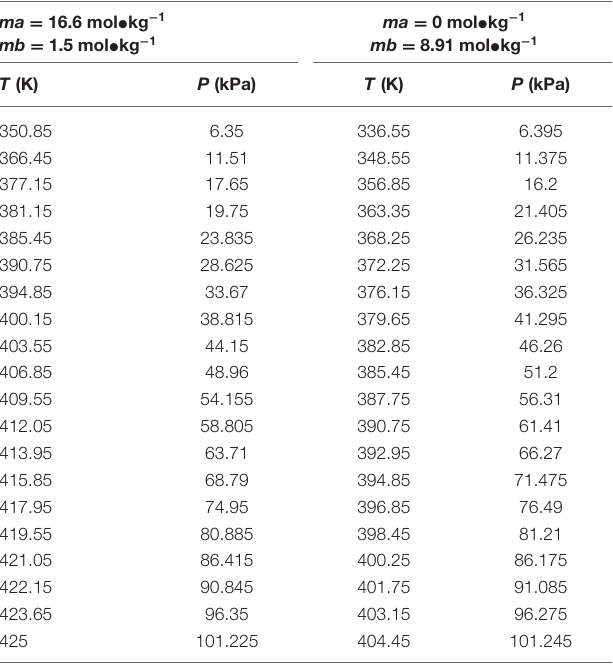
TABLE 6 | Experimental VLE data for temperature T , pressure P , and molality m ( ma— LiBr, mb— CaCl 2 ) for the LiBr + CaCl 2 + H 2 O system.